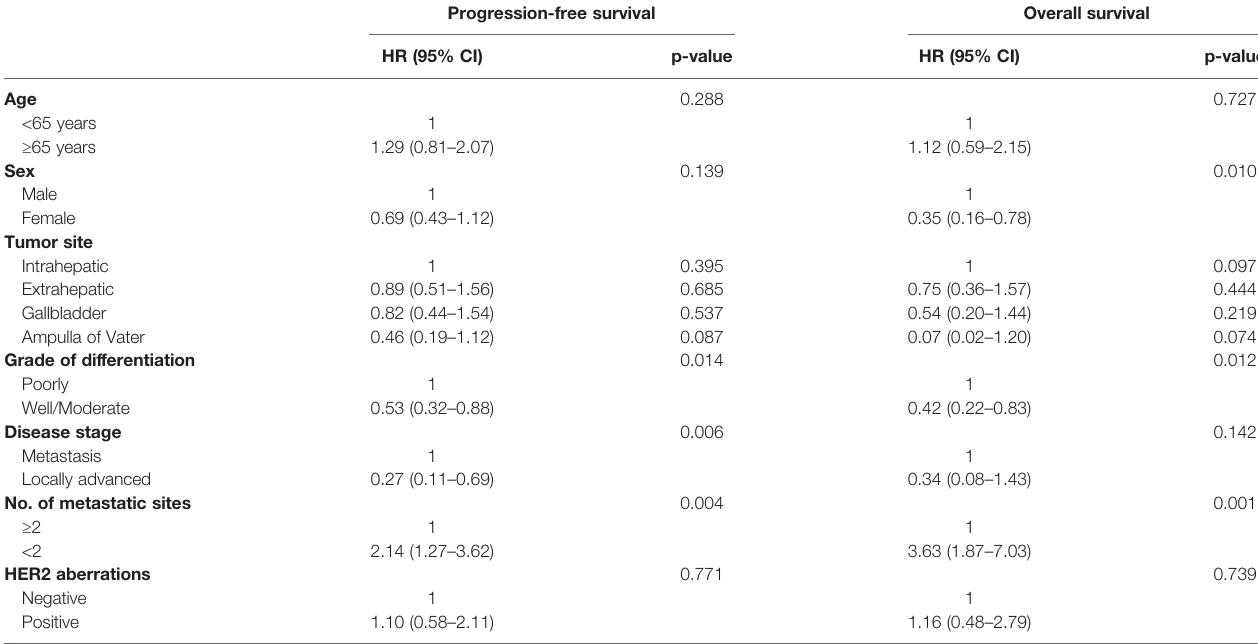
TABLE 3 | Univariate analysis of progression-free survival and overall survival after gemcitabine/cisplatin. Progression-free